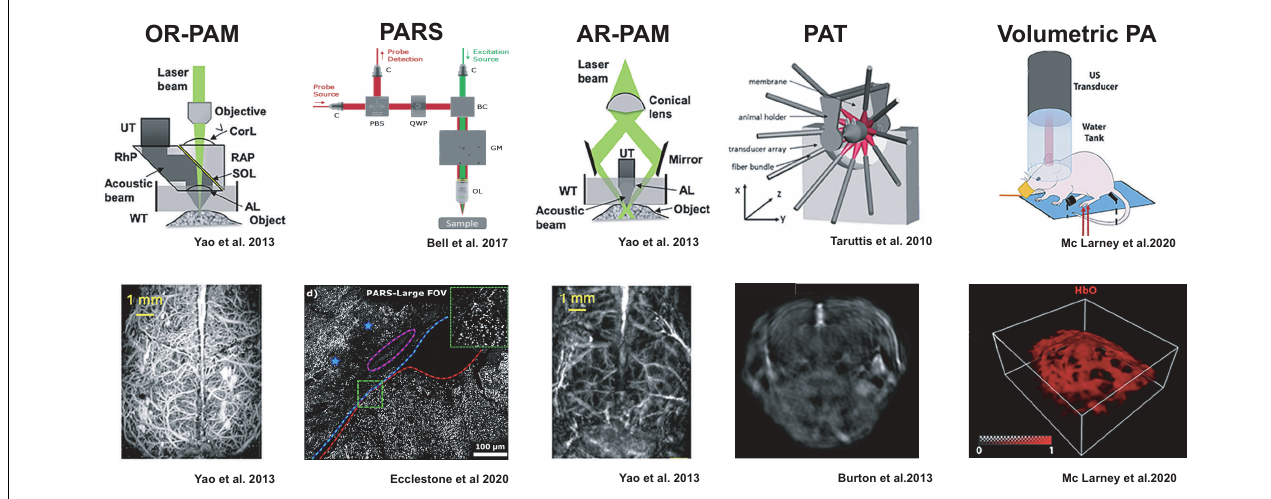
FIGURE 1 | Detection geometries for photoacoustic imaging with example results from neuroimaging. The figures were adapted from the respective references with permission from the